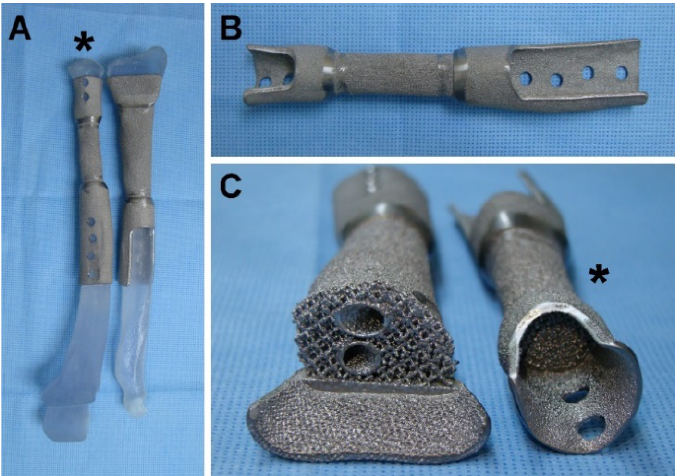
Figure 3. Bone implants of the radius and the ulna. Photographs showing ( A ) 3D-printed implants of both forearm bones with the host bone models, ( B ) a volar view of the ulnar implant, and ( C ) the mesh-structured junctional area of the implants. The asterisk ( * ) indicates the ulnar implant.